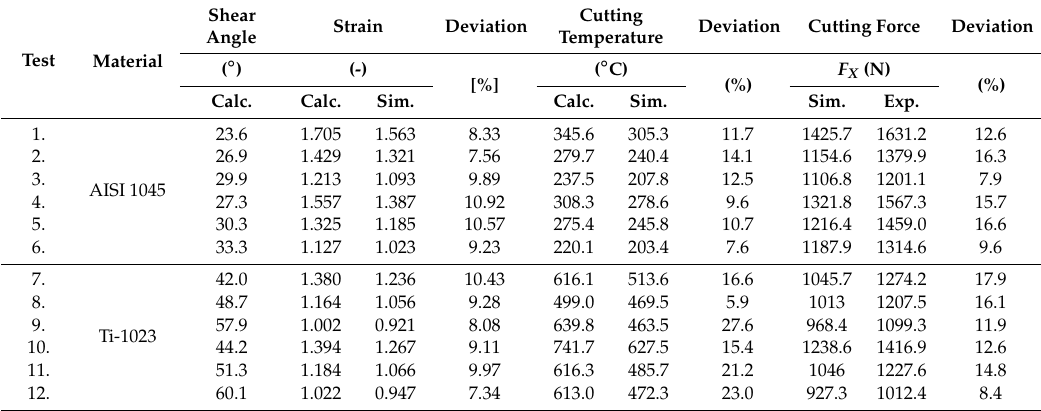
Table 5. Comparison of predicted and experimental forces in orthogonal